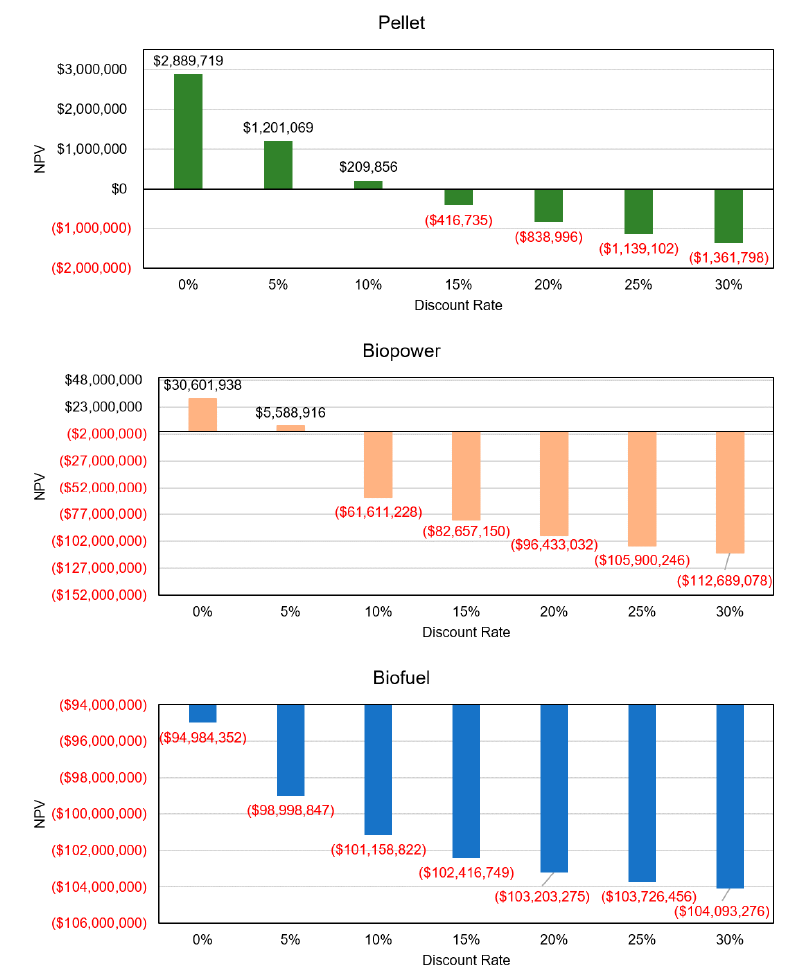
Figure 4. The impacts of discount rate on net present value for pellet, biopower, and biofuel production.